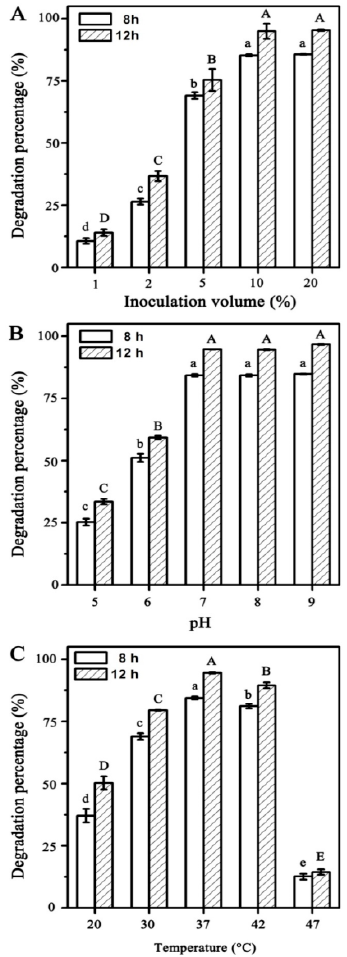
Figure 1. E ff ects of inoculation volume ( A ), temperature ( B ) and pH ( C ) on chlorpyrifos degradation by Figure 1. Effects of inoculation volume (A), temperature (B) and pH (C) on chlorpyrifos degradation strain X1 T in 8 and 12 h. ( A ) The e ff ects of inoculation volumes on the biodegradation of chlorpyrifos by strain X1 T in 8 and 12 h. (A) The effects of inoculation volumes on the biodegradation of at level of 1–20% under the condition of 37 ◦ C and pH 7. ( B ) The e ff ects of temperature on chlorpyrifos chlorpyrifos at level of 1–20% under the condition of 37 °C and pH 7. (B) The effects of temperature degradation at 20–47 ◦ C under the condition of 10% inoculation volumes and pH 7. ( C ) The e ff ects of on chlorpyrifos degradation at 20–47 °C under the condition of 10% inoculation volumes and pH 7. pH on the biodegradation of chlorpyrifos at 5–9 under the condition of 10% inoculation volumes and (C) The effects of pH on the biodegradation of chlorpyrifos at 5–9 under the condition of 10% 37 ◦ C. All values are means ± standard deviation of triplicate measurements. Mean values with the inoculation volumes and 37 °C. All values are means ± standard deviation of triplicate same letter (a, b, c, d, e or A, B, C, D, E) are not significantly di ff erent with reaction time (8 or 12 h) by measurements. Mean values with the same letter (a, b, c, d, e or A, B, C, D, E) are not significantly LSD at the 5% different with reaction time (8 or 12 h) by LSD at the 5% level.